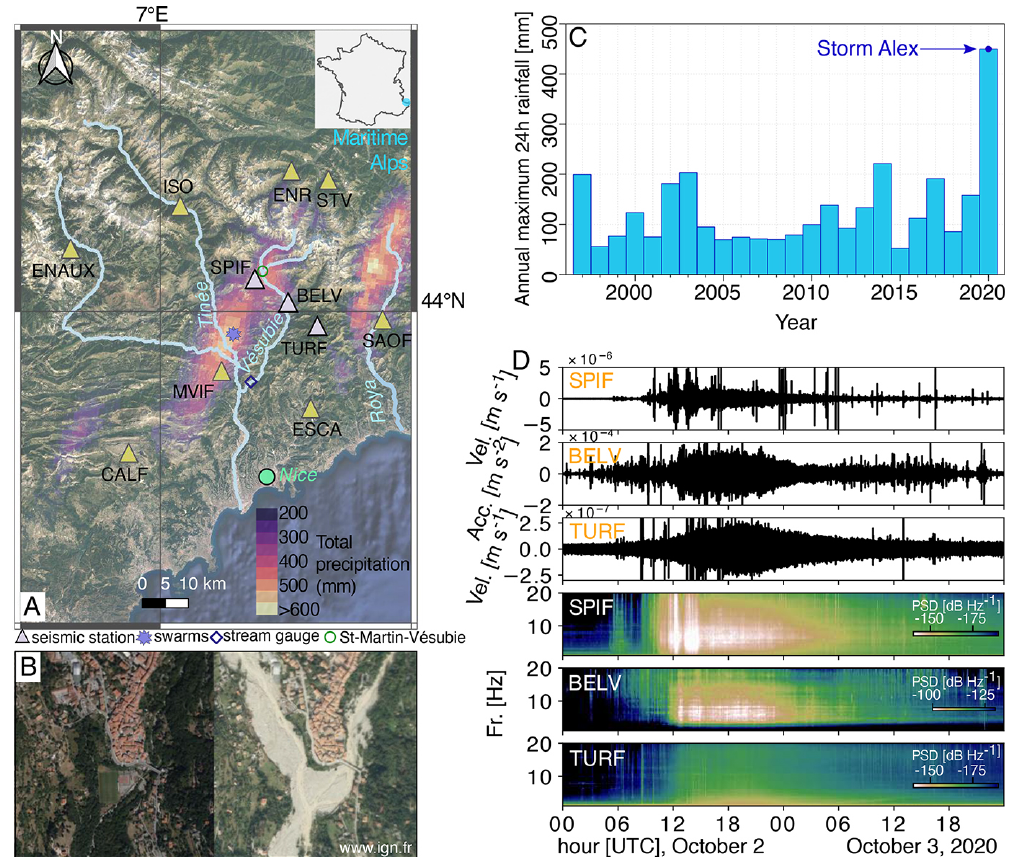
Figure 1. Study area, rainfall measurements, and recorded seismic data. (a) Study site and permanent Résif seismological stations su- perimposed over the total rainfall amount estimated by the ANTILOPE database (from 06:00UTC on 2 October 2020 to 06:00UTC on 3 October 2020). Background map source: © Google Maps 2021. The location of the earthquake swarms studied here is indicated by a purple star. The location in France of the study area is marked by a blue dot on the inset map. (b) The village of Saint-Martin-Vésubie before (summer 2020) and after the storm episode (source: IGN, 2020). (c) Annual maximum daily rainfall rate from the COMEPHORE database (hourly rainfall estimated on pixels of 1km 2 , available since 1997; Tabary et al., 2012) calculated over the 25km 2 rectangle shown in Fig. B3a. (d) Vertical ground velocity at stations SPIF and TURF and vertical ground acceleration at station BELV filtered in 1–20Hz (top) and their seismic power (bottom) recorded during 48h, between 00:00UTC on 2 October and 00:00UTC on 4 October. The frequency axes are limited to